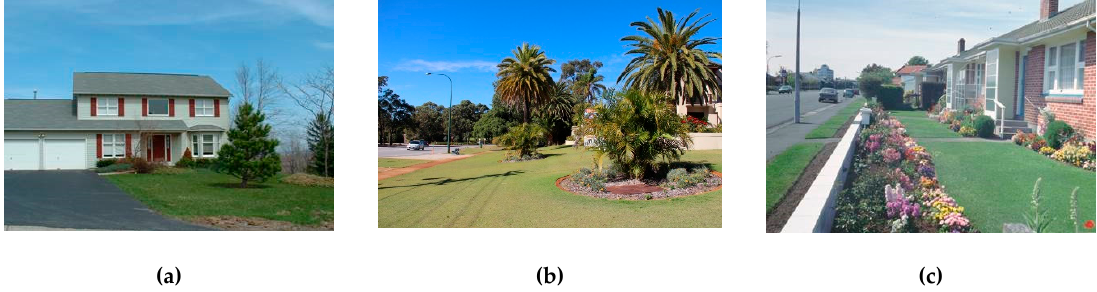
Figure 6. Lawns in private gardens: ( a ) USA (Syracuse, NY), ( b ) Australia (Perth) and ( c ) New Zealand (Christchurch). Lawns are obligatory elements of suburbia. Photos: M. Ignatieva.